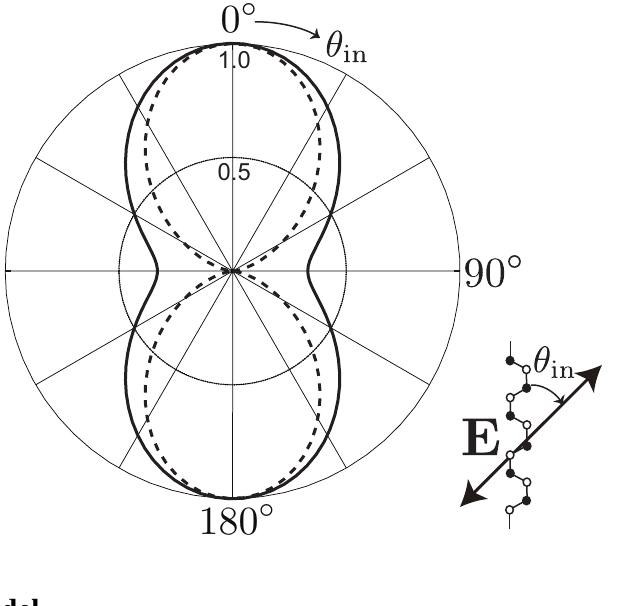
Figure 5. Polar plot for the D band intensity. The parameters for the solid curve are a = 1 , b = 1 / 3 , and c = 0 , while those for the dashed curve are a = 1 and b = c = 0 . 0 1.0